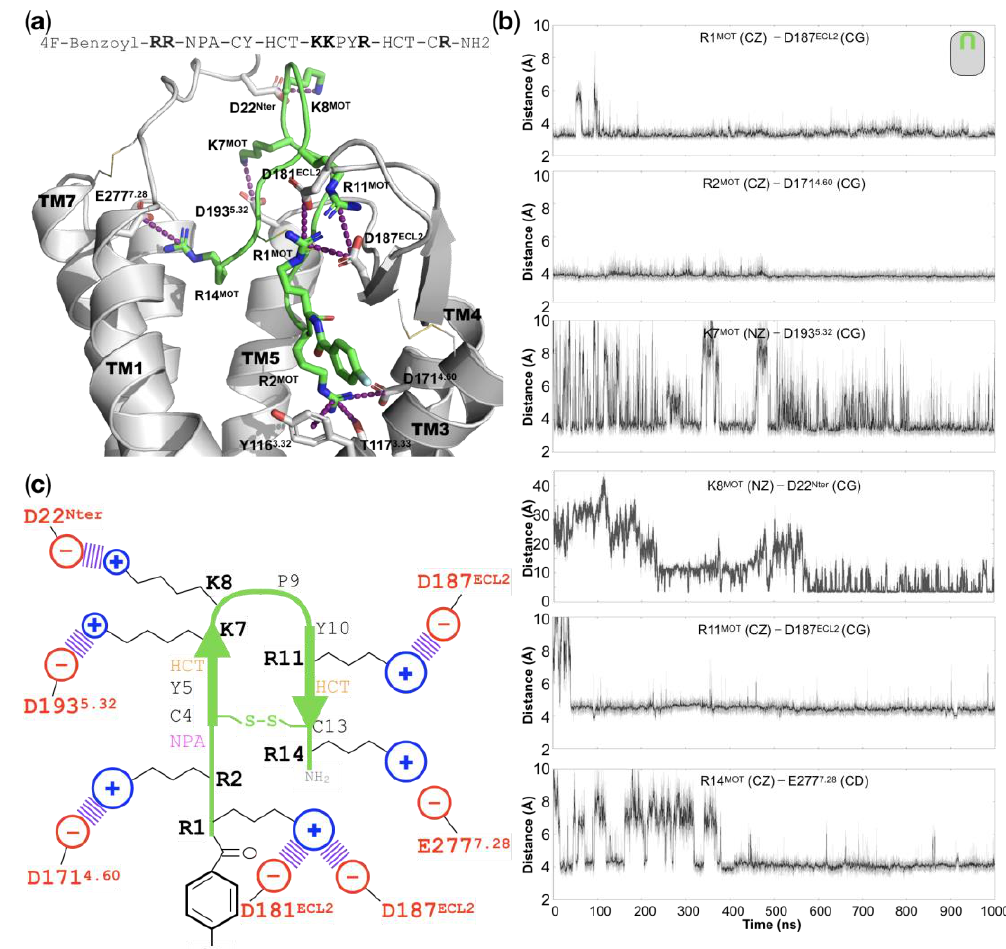
Figure 4. Interactions in the motixafortide/CXCR4 protein complex: ( a ) Representative structure of the final stages from the atomistic MD simulation of the motixafortide/CXCR4 complex, where we can observe that all of the cationic residues of motixafortide are involved in charge–charge interactions with residues in the ligand-binding site of CXCR4 (see purple dashed lines). For the sake of clarity, TM6 is not displayed, and the sequence of motixafortide is depicted at the top of the panel, where its six basic residues (R1, R2, K7, K8, R11, and R14) are highlighted. ( b ) The time evolution plots of distances involving the interactions in the six basic residues from motixafortide (the moving average is colored black, while the primary data are colored gray). ( c ) Schematic representation of the charge – charge interactions that stabilize the molecular pose of motixafortide in the orthosteric binding site of CXCR4 (see also Video S1).